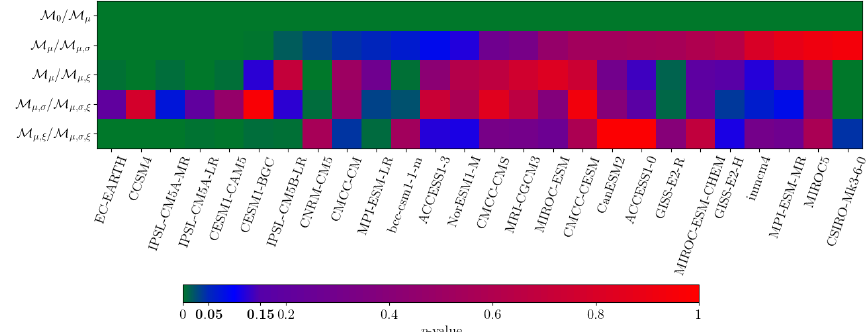
Figure 3. Results of likelihood ratio test (LRT) to find which GEV model can be used for each CMIP5 model ( x axis). M 0 is the stationary GEV model. M µ is the GEV model where µ is nonstationary, etc. The y axis labels indicate the test of the right model against the left model (see Fig. 2). For example, the first line test is if M µ (right) is more adapted than M 0 (left). The color map gives the p value of the LRT. A value higher than 0 . 15 (red) indicates that the new model is rejected. A value lower than 0 . 05 (green) indicates that the new model is accepted. The values between 0 . 05 and 0 . 15 (blue) are discussed in Sect. 3.3.